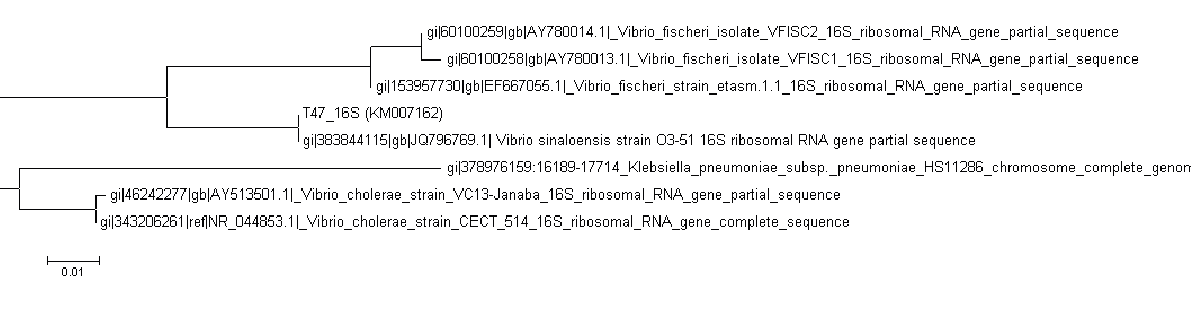
Figure 2. Phylogenetic analysis of strain T47. Phylogenetic tree reconstructed using the Maximum likelihood algorithm showing phylogenetic relationships of strain T47 to members of the other species of the genus Vibrio . Bar, 1 substitution per 100 nucleotides positions. Gene accession numbers are